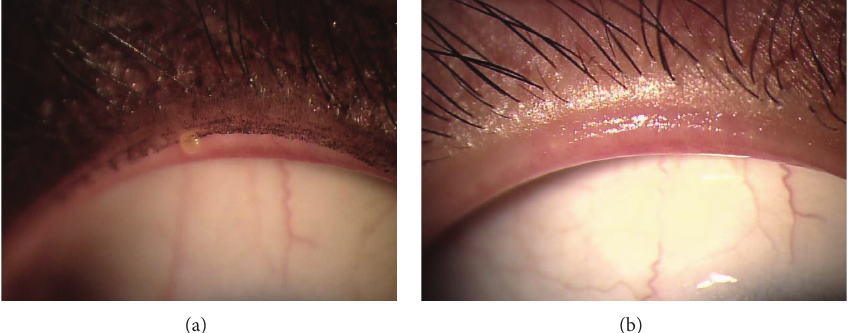
Figure 7: Tapioca sign in the upper eyelid, with improvement after 4 weeks of intervention. (a) Week 0, adhering to eyeliner inside eyelid margin. (b) Week 4, after using artificial tears and Eye Shampoo.